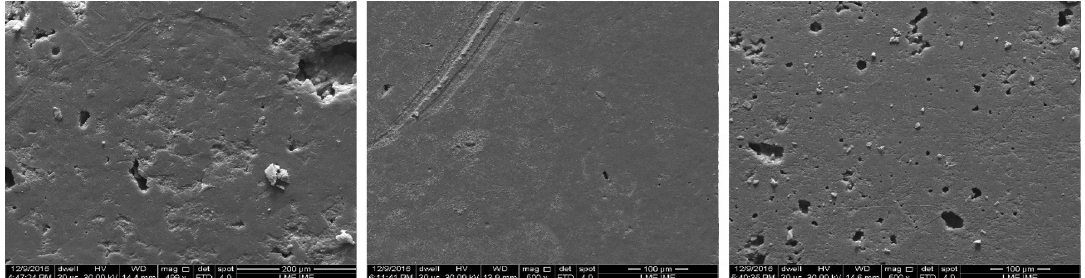
Figure 14. SEM electron micrographs of the surfaces surface of the PET/T-GCW composites: (a) 50/50 (b) 60/40 and (c) 80/20.